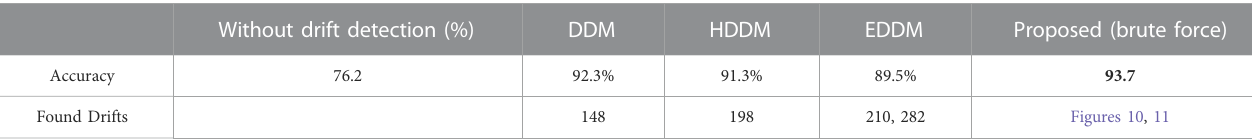
TABLE 1 Detected drifts and